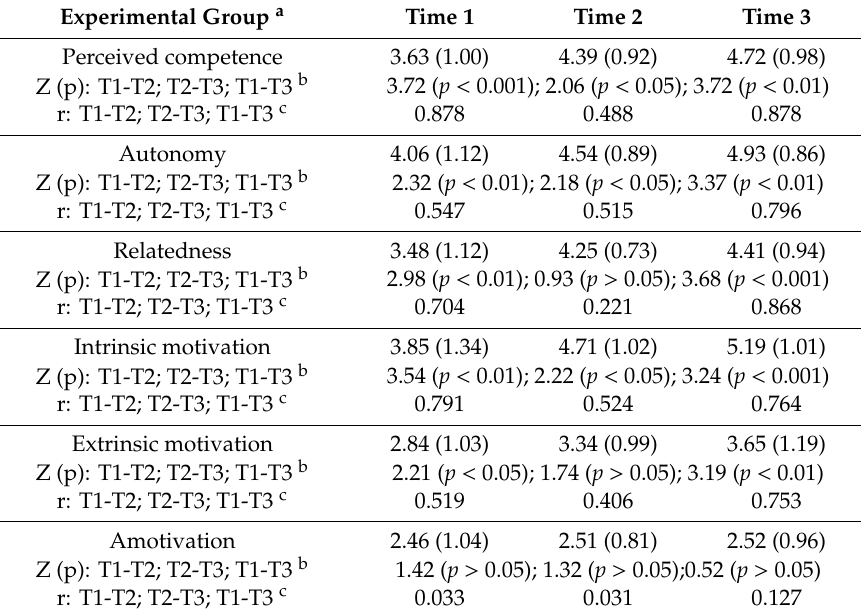
Table 4. Experimental Group di ff erences in BPN and motivation